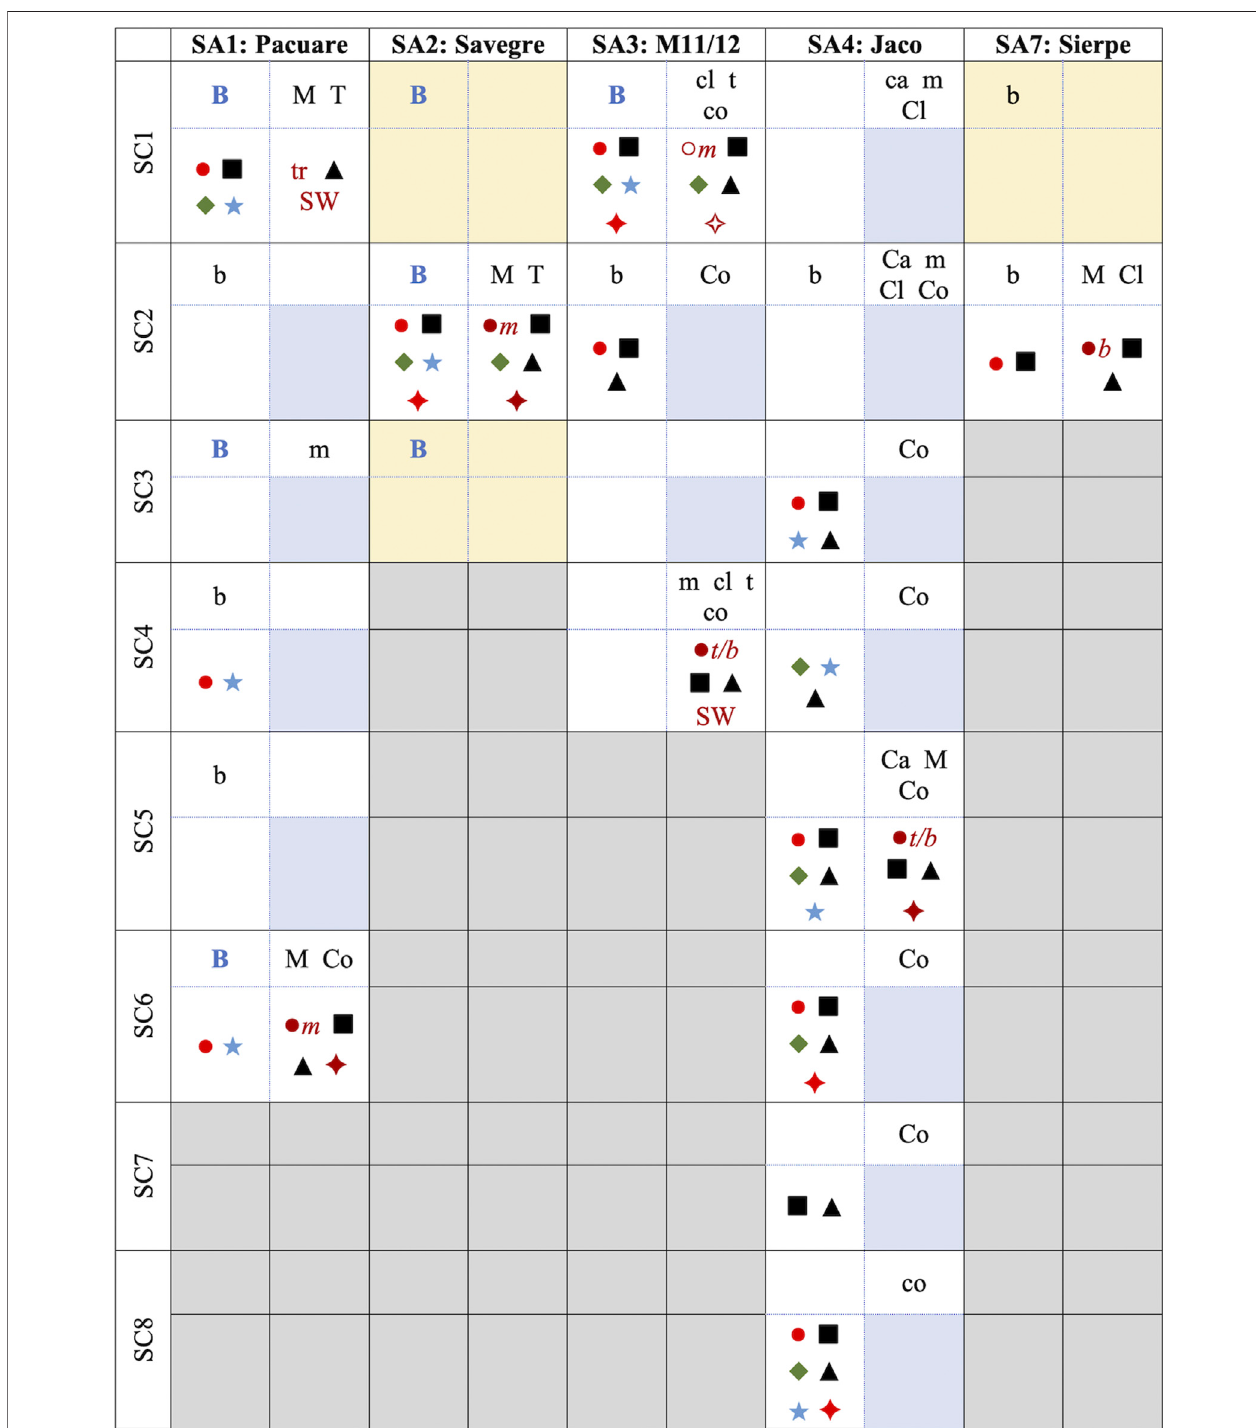
FIGURE10| Synthesisofseepresults.Dataarrangedbyseeparray(columns)andcluster(rows);grayboxesindicatenoseepclusterde fi ned,orangeboxesre fl ect seep clusters unvisited by ROV, and blue boxes visited by ROV but no samples obtained. Each seep cluster divided into 4 observation types: 1) acoustic anomalies/ bubble plumes (upper left); B : 5 + plumes, b: < 5 plumes, and blank (cid:2) 0 plumes; 2) observed seep biota and substrate (upper right) where upper case indicates major component and lower case is minor component; M: mats; T: tubeworms; Cl: clams; Co: corals; Ca: carbonate; 3) mass spectrometer anomalies (lower left); C : methane; ethane; ◆ : propane; ▲ : benzene; + : carbon dioxide; ✦ : hydrogen sul fi de); 4) pore water and head-space gas results from push cores (lower right); C : methane > 20 mM; ○ :methane (cid:2) 1 – 10 mM;tr:methane < 0.1 mM;ethane; ◆ :propane; ▲ :benzene; ✦ :sulfate (cid:2) 0 – 5 mM; ✧ :sulfate (cid:2) 2 – 20 mM;SW:sulfate (cid:2) > 20 mM; letters following methane symbols indicate δ 13 C ratios: t : -40 to − 50 ‰ ; m: − 50 to − 65 ‰ ; b: < − 65 ‰ .